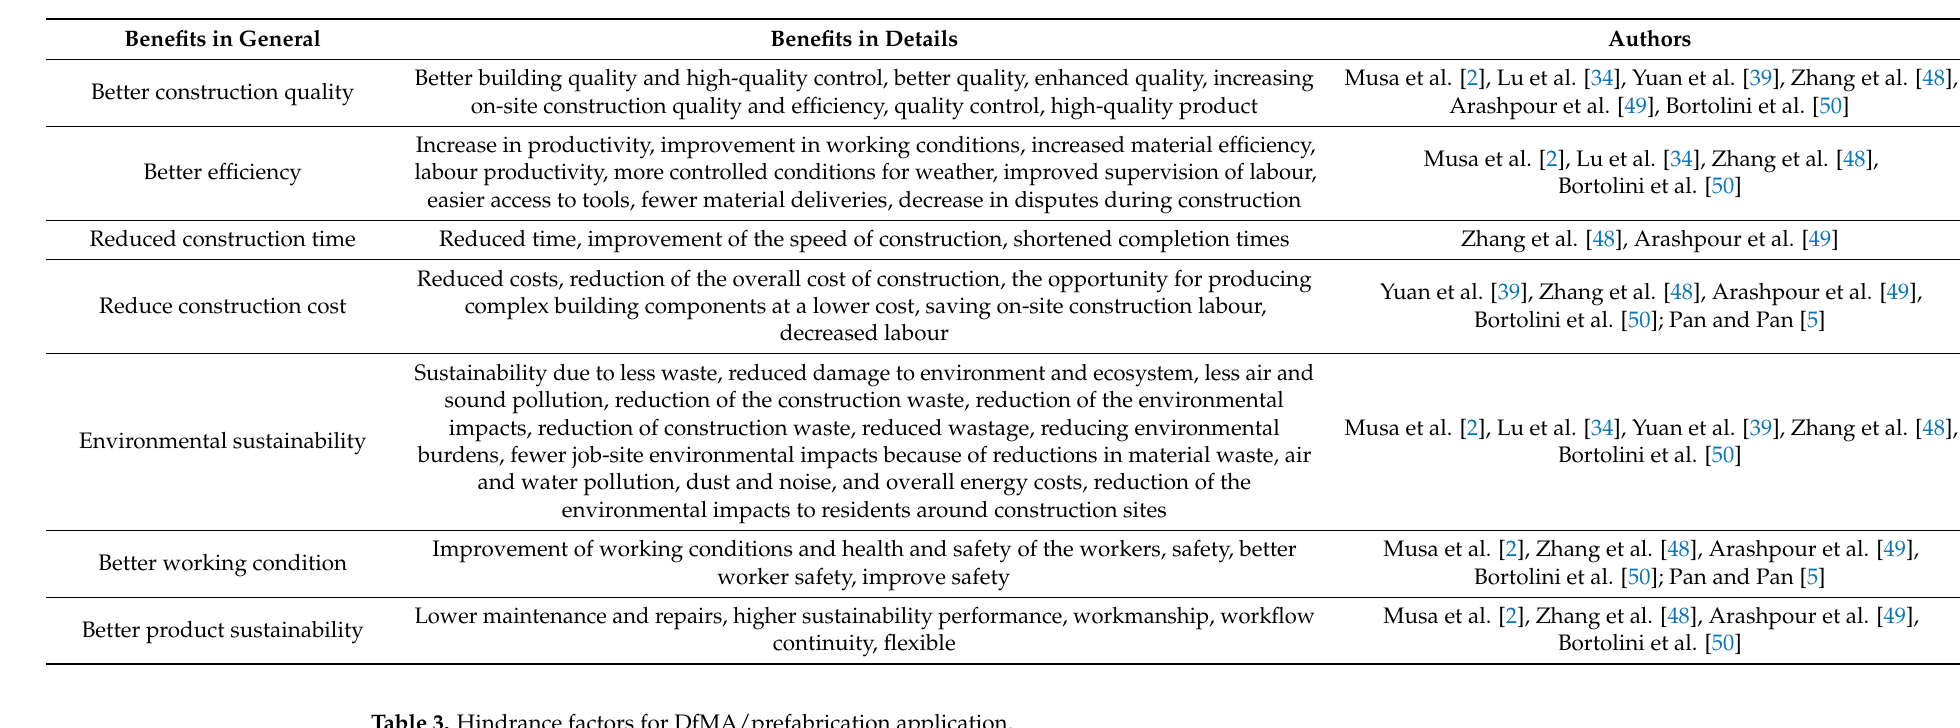
Table 2. Benefits of prefabrication and off-site construction.